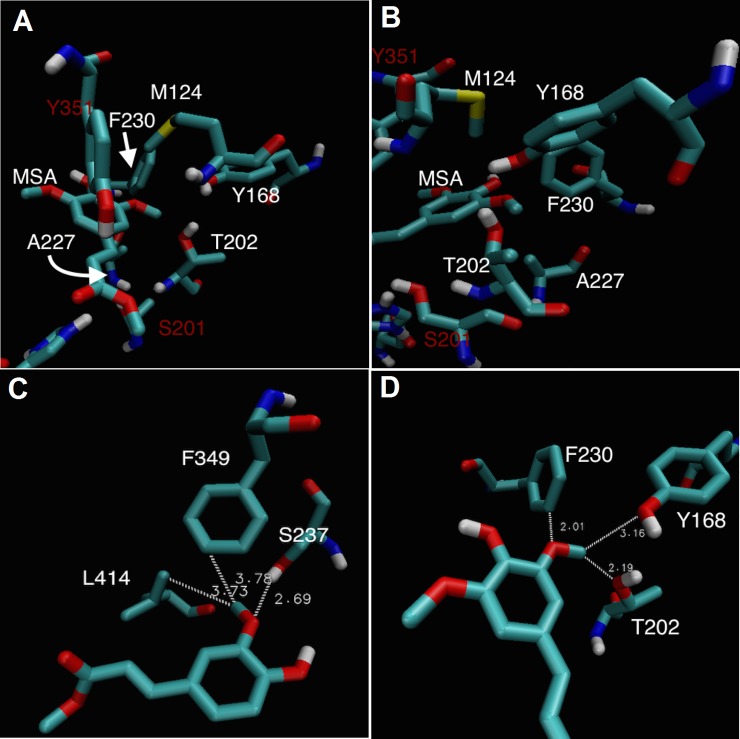
Relevant residues for determining binding of ligand onto FoFaeC wild type.(A) and (B) Binding of MSA representing different angles with Tyr351 and Ser201 residues shown for orientation in red. (C) MFA and (D) MSA binding in reversed orientation showing relevant residues involved in side group recognition.